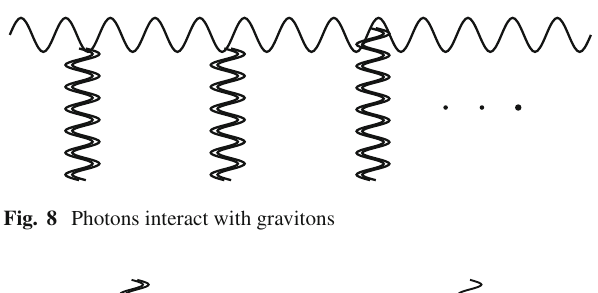
Fig. 8 Photons interact with gravitons